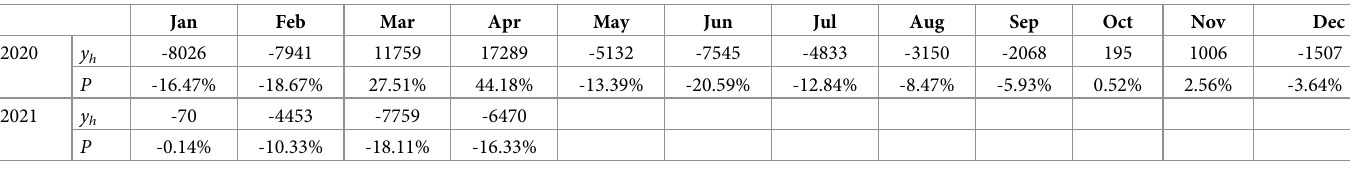
Table 6. Excess of deaths for the Spanish